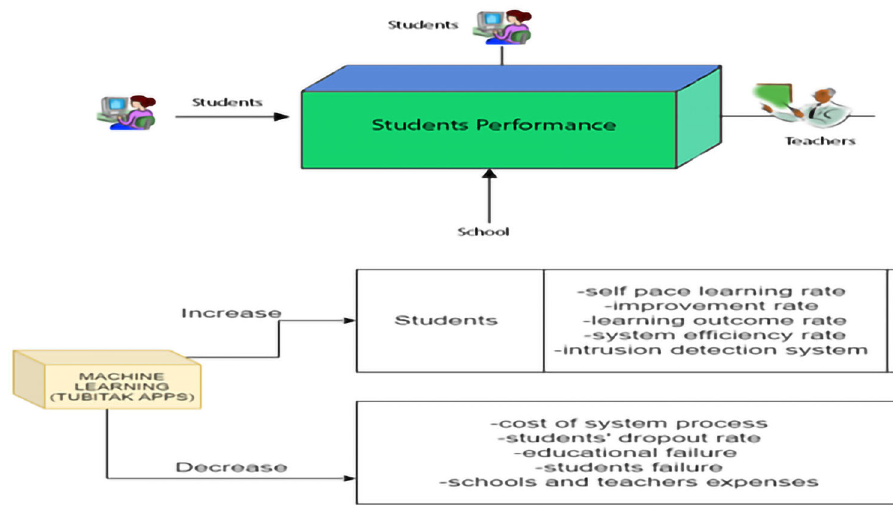
Fig. 4 The system how Machine Learning is enhancing the Future of Education.